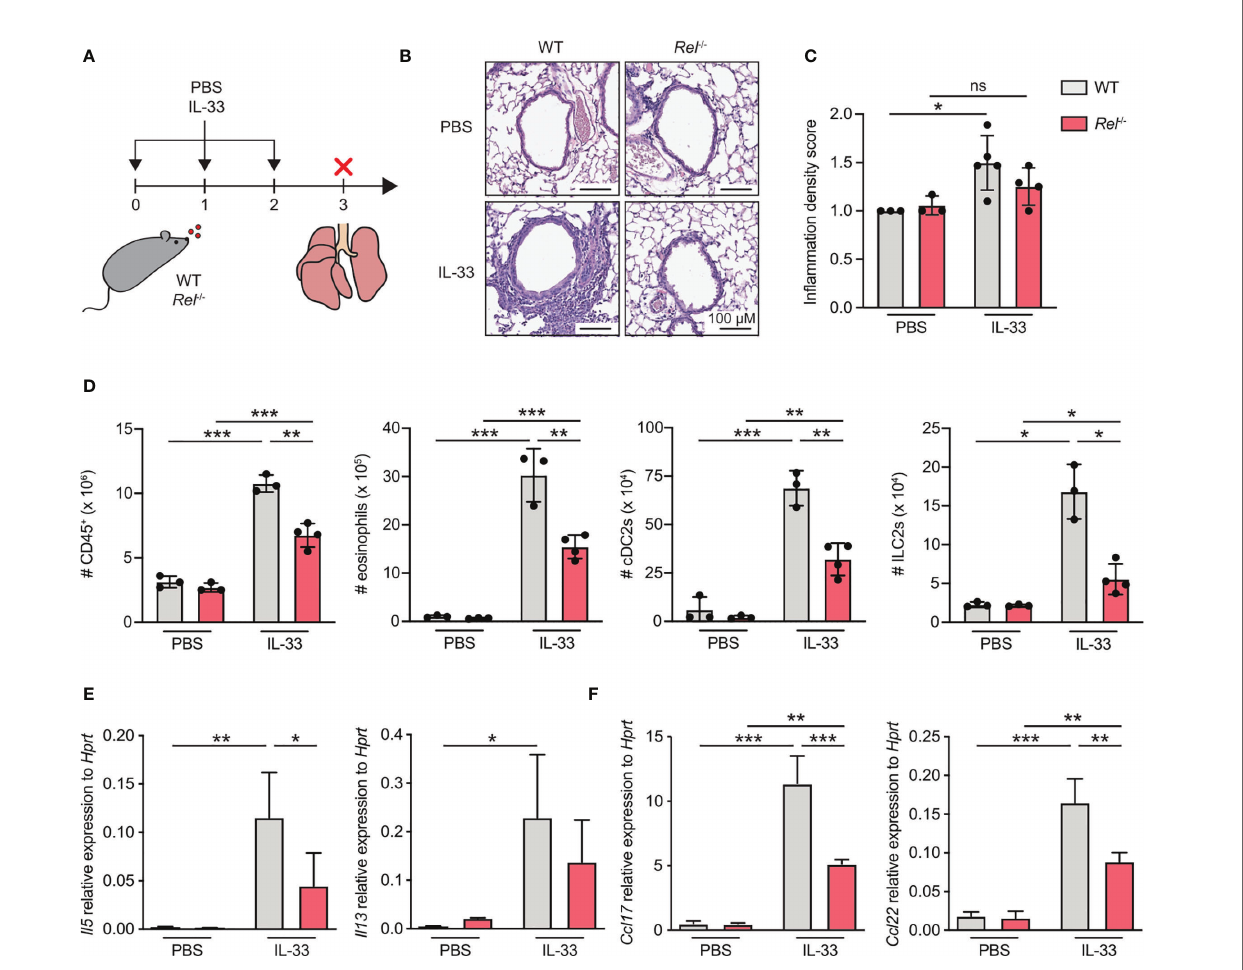
FIGURE 1 | c-Rel is a critical mediator of innate type 2 immune responses. (A) Wild-type (WT) and c-Rel-de fi cient ( Rel − / − ) mice were intranasally challenged for three consecutive days (day 0, 1, and 2) with phosphate-buffered saline (PBS) as a control or IL-33 (500 ng/mouse). Lungs were isolated and analyzed 24 h after the last challenge (day 3). (B) Microscopy of lung sections stained with hematoxylin and eosin (H&E) from WT (left panel) and Rel − / − mice (right panel) treated with PBS or IL-33. Scale bars, 100 µM. (C) Pathology score of in fl ammatory in fi ltration density assessed microscopically from H&E-stained lung sections. ns, not signi fi cant. (D) Total numbers of CD45 + leukocytes, eosinophils, type 2 conventional dendritic cells (cDC2s), and group 2 innate lymphoid cells (ILC2s) in lungs of WT (gray) or Rel − / − (red) mice were determined by fl ow cytometric analysis. Expression levels of (E) Il5 and Il13 as well as (F) Ccl17 and Ccl22 in whole lung tissue of WT (gray) and Rel − / − (red) animals were assessed by qRT-PCR. Data are representative of two independent experiments with n = 3 – 4 mice per group. Data are shown as mean ± SD with *p < 0.05, **p < 0.01, ***p < 0.001 as determined by one-way ANOVA followed by Tukey ’ s multiple comparisons